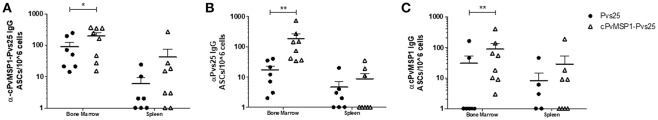
IgG-producing long-lived plasma cells. Antigen-specific IgG plasma cells present in the bone marrow or spleen of CB6F1/J mice immunized with Pvs25 (closed circles, n = 7), cPvMSP1-Pvs25 (open triangles, n = 8) were analyzed at two years post first immunization. IgG long-lived plasma cells specific to (A) cPvMSP1-Pvs25, (B) Pvs25, and (C) cPvMSP1 are shown. Statistical analysis was conducted using Mann Whitney. Statistically significant differences are denoted by *p < 0.05 and **p < 0.01.